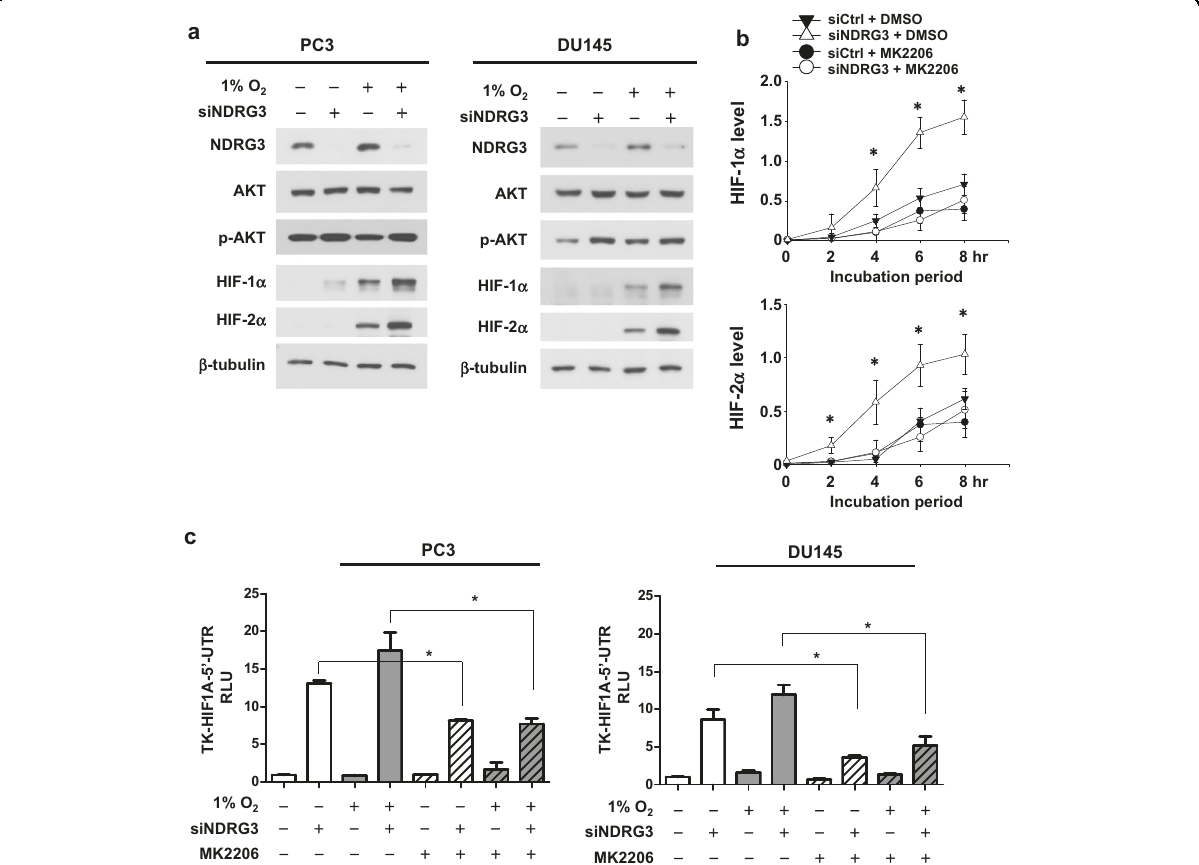
Fig. 3 NDRG3 inhibits the AKT-dependent translation of HIF-1 α . a Phospho-AKT (S473) and total AKT levels were analyzed in PC3 and DU145 cells that were transfected with siNDRG3 and incubated under hypoxia for 24 h. b The transfected PC3 or DU145 cells were pre-treated with 1 μ M MK-2206 for 16 h and incubated with 15 μ M MG132 for the indicated times. Western blot intensities were analyzed using ImageJ, and the relative band intensities were normalized to the corresponding β -tubulin intensities. Each symbol represents the mean ± s.d. ( n = 3). c The TK- HIF1A 5 ′ UTR- luciferase reporter and the CMV- β -galactosidase plasmids were co-transfected with siCtrl or siNDRG3 into PC3 and DU145 cells. After stabilization for 24 h, the cells were incubated with DMSO or MK-2206 under normoxia or hypoxia for 24 h. Luciferase activities (means + s.d., n = 3) were normalized to β -galactosidase activities. * denotes P < 0.05 between the indicated